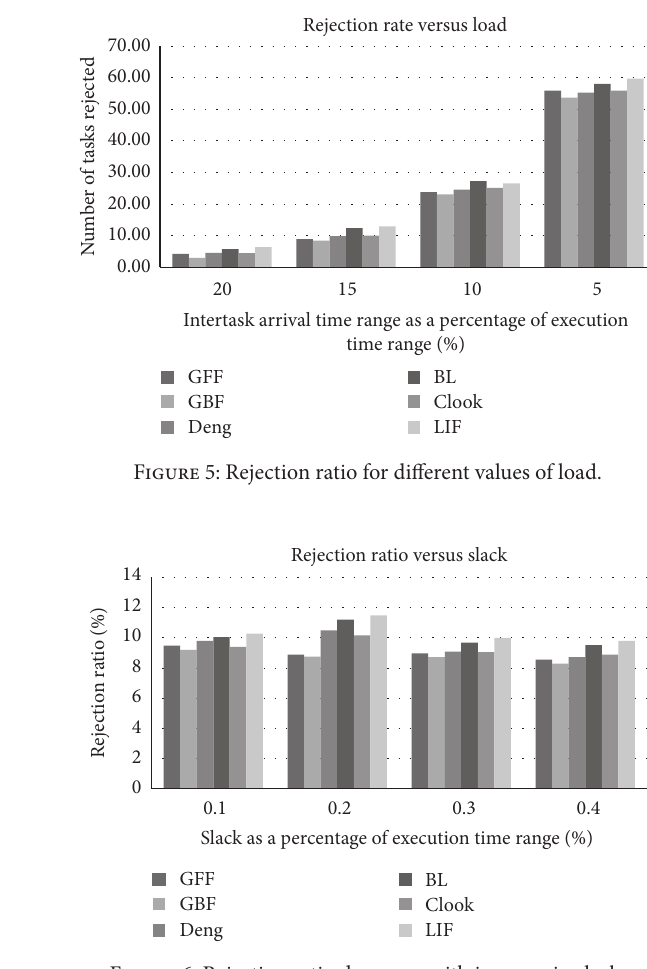
Figure 4: Variations of rejection rate with respect to percentage of large sized task in the dataset.